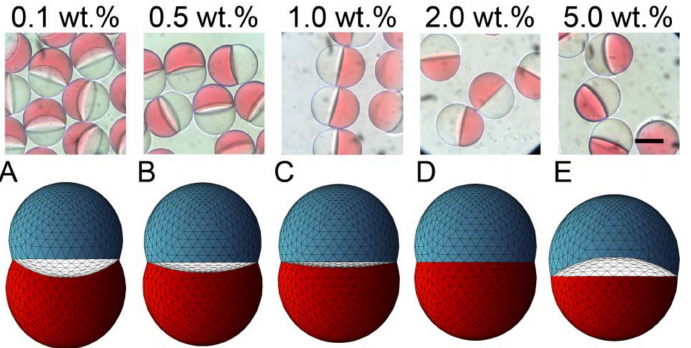
Figure 3. Effect of surfactant concentration on the morphology of Janus droplets. Photomicrographs showing structural variation of Janus droplets carrying surfactant at concentrations ranging from 0.1 to 5.0 wt.% (top) and their corresponding simulated three-dimensional shapes (( A – E ), bottom). Flow conditions were Q m = Q s = 0.3 mL h − 1 , and Q c = 8.0 mL h − 1 . Scale bar: 100 µ